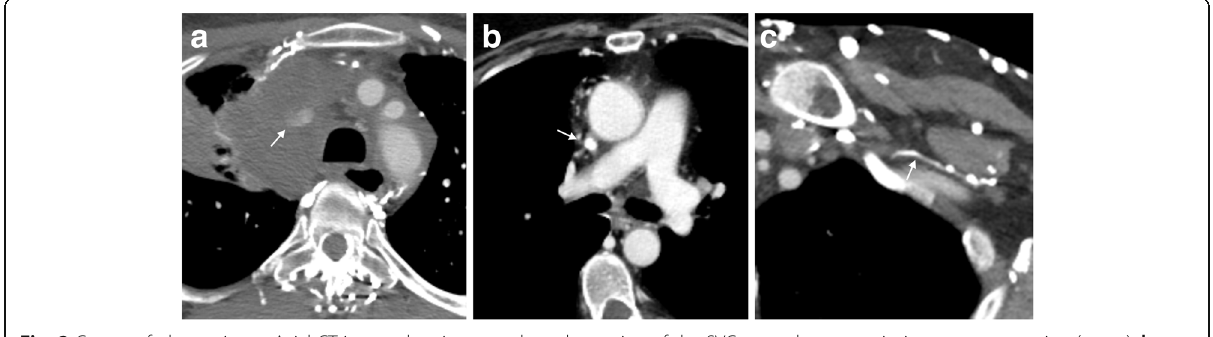
Fig. 2 Causes of obstruction. a Axial CT image showing complete obstruction of the SVC secondary to extrinsic mass compression (arrow). b Axial CT image demonstrating SVC narrowing/occlusion (arrow) secondary to chronic indwelling catheter. c Axial CT image demonstrating intraluminal obstruction of the left axillary vein from a chronic thrombus